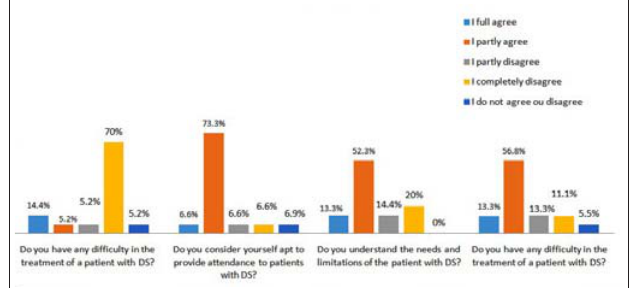
Fig. 2. Likert Scale. Source: Direct Research Parnaíba 2014